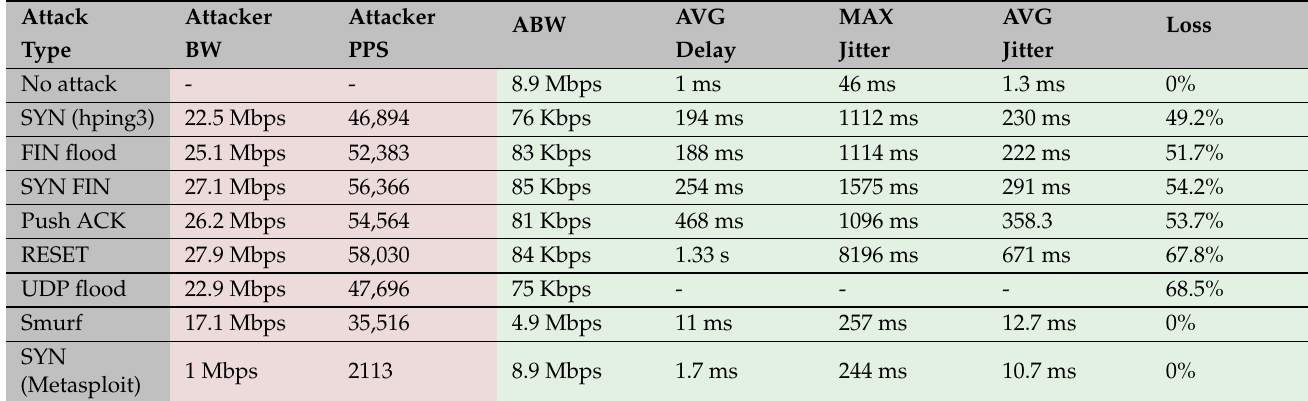
Table 3. Denial of Service Verification